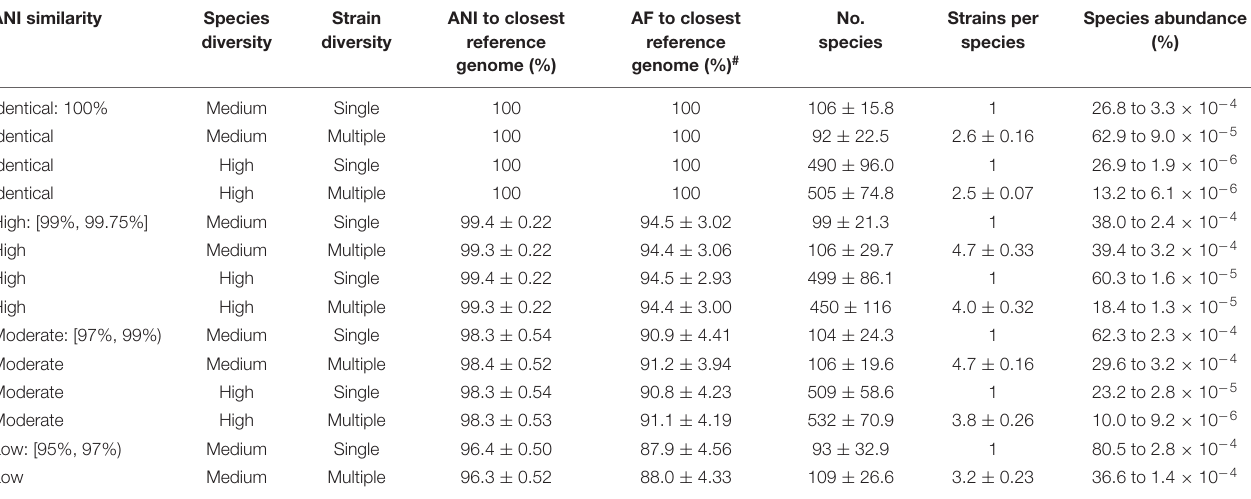
TABLE 2 | Properties of the 140 in silico mock communities averaged over the 10 replicates from each